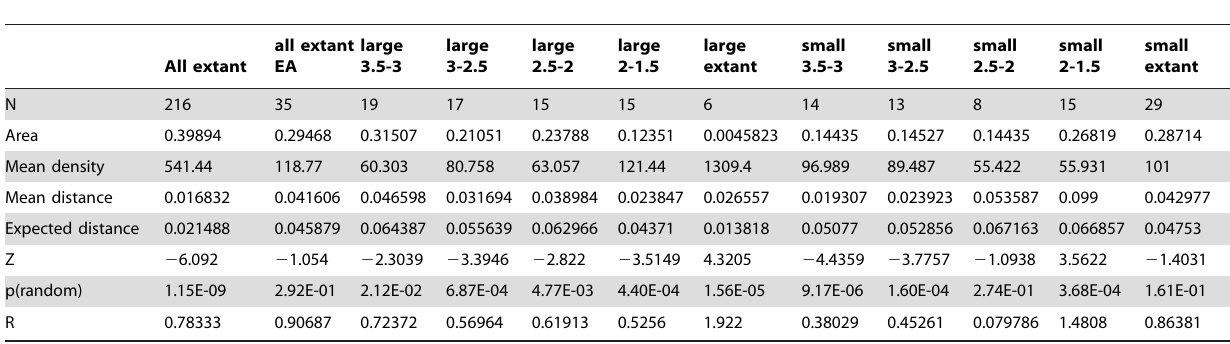
Table 1. Basic statistics of carnivoran morphospace as labeled, and results of the nearest neighbor analyses of these morphospace